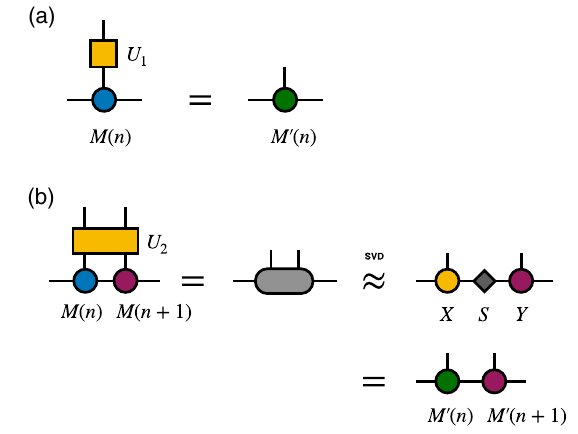
FIG. 2. (a) Applying a single qubit gate to a MPS can be done without approximation by multiplying the gate by a single MPS tensor. (b) To apply a 2-qubit gate to qubits n and n þ 1 , one contracts the corresponding tensors together, then applies the gate. To restore the MPS form, the resulting tensor is decomposed with a SVD truncated to keep the largest χ singular values, and the matrix of singular values is multiplied into one of the unitary factors X or Y